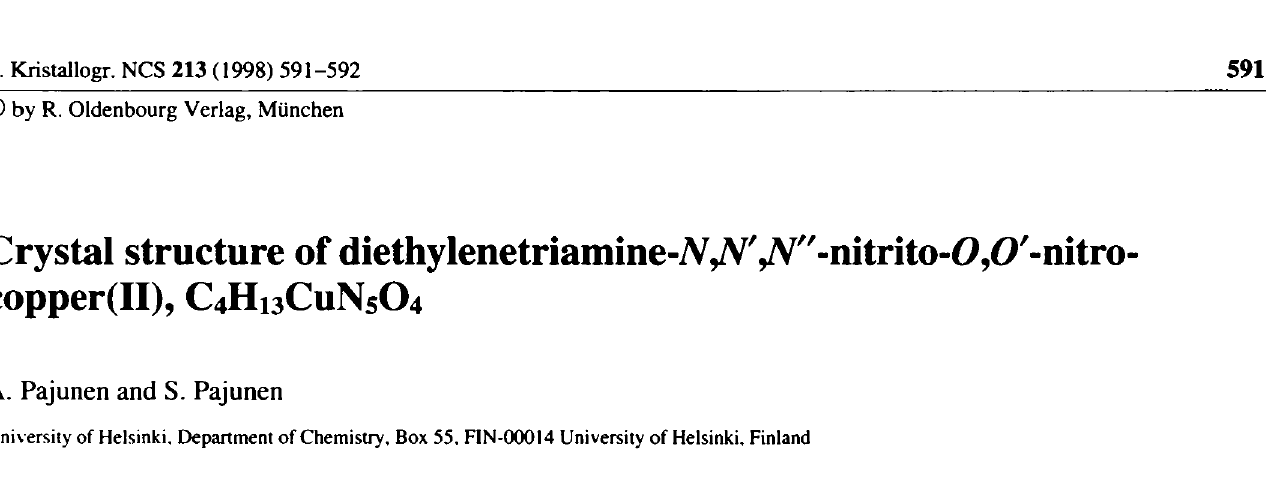
Table 1. Parameters used for the X-ray data collection